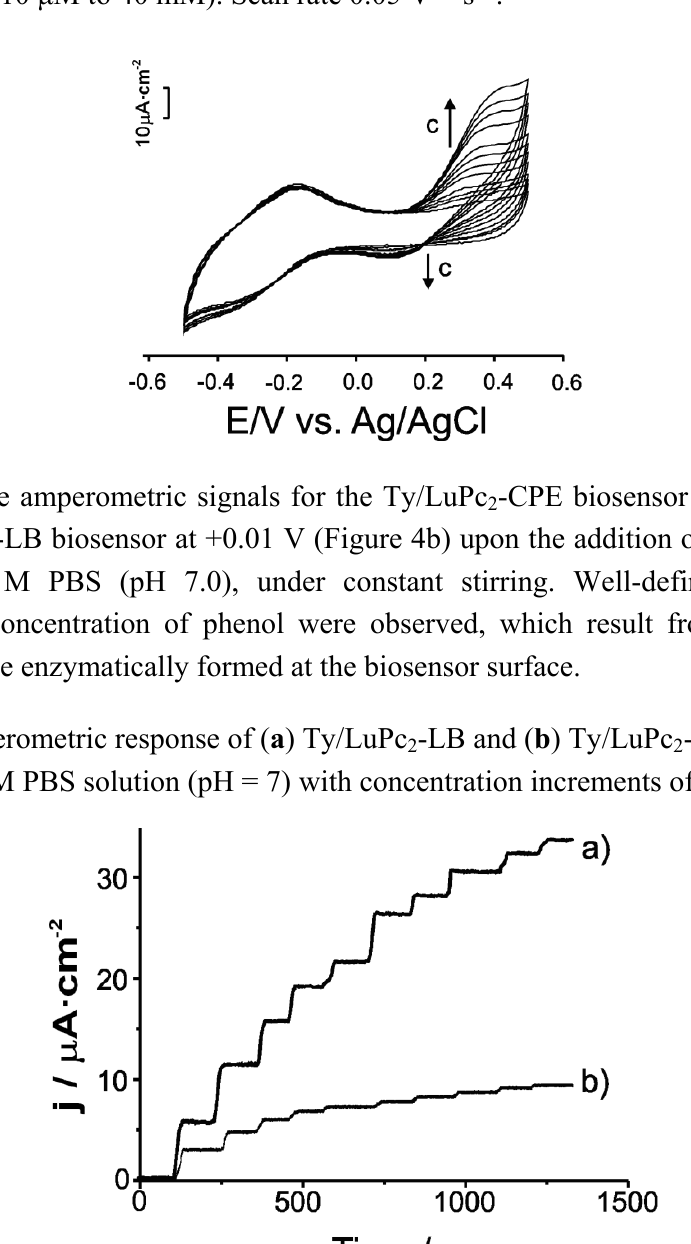
-LB electrode immersed in catechin 2